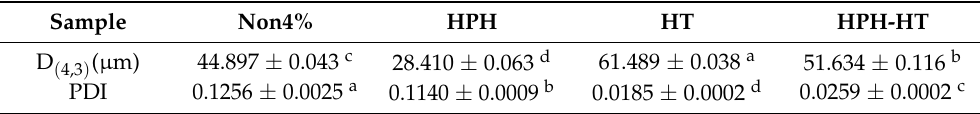
Table 2. Mean diameter D (4,3) and polydispersity Index (PDI) of DCF dispersions treated in different ways. Sample